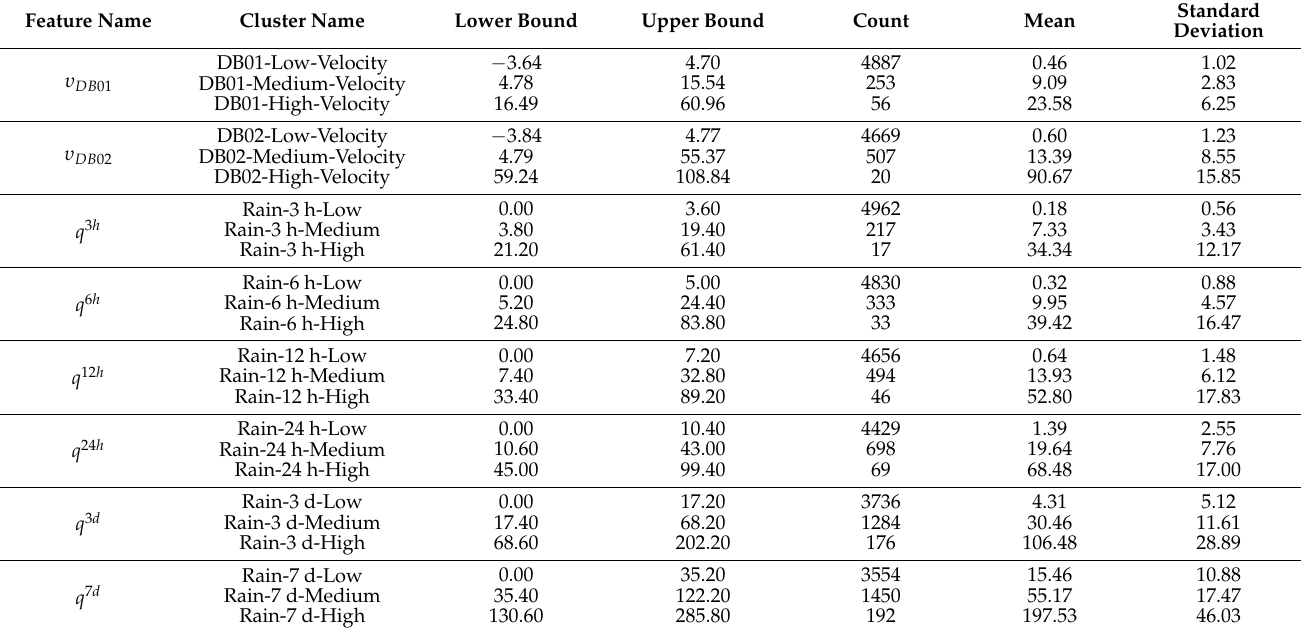
Table 2. Interval range and sample size of all feature clustering